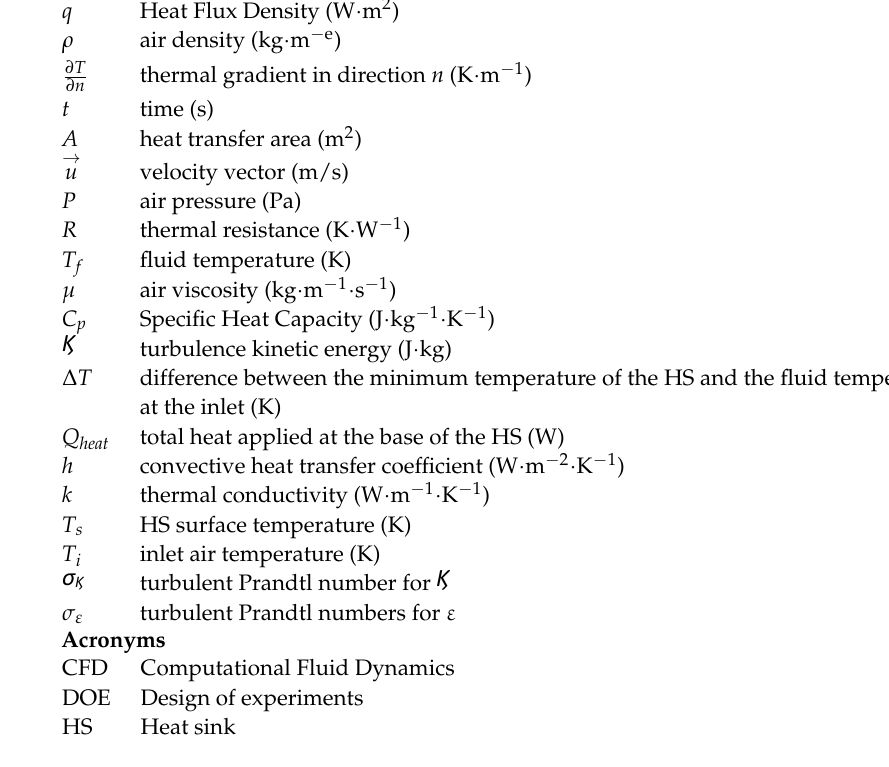
Figure 2. Lattice heat sink mesh.